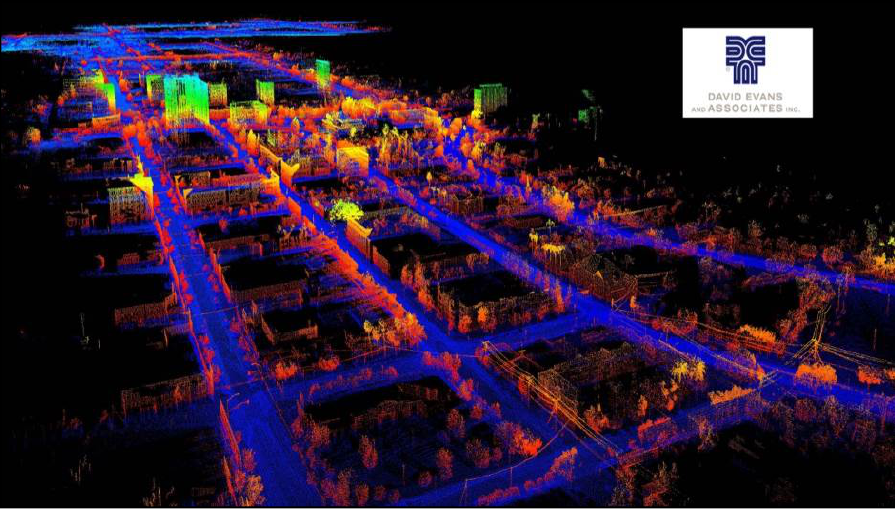
Figure 3. Point cloud data of downtown Santa Ana, CA obtained through MLS (Courtesy of DEA).